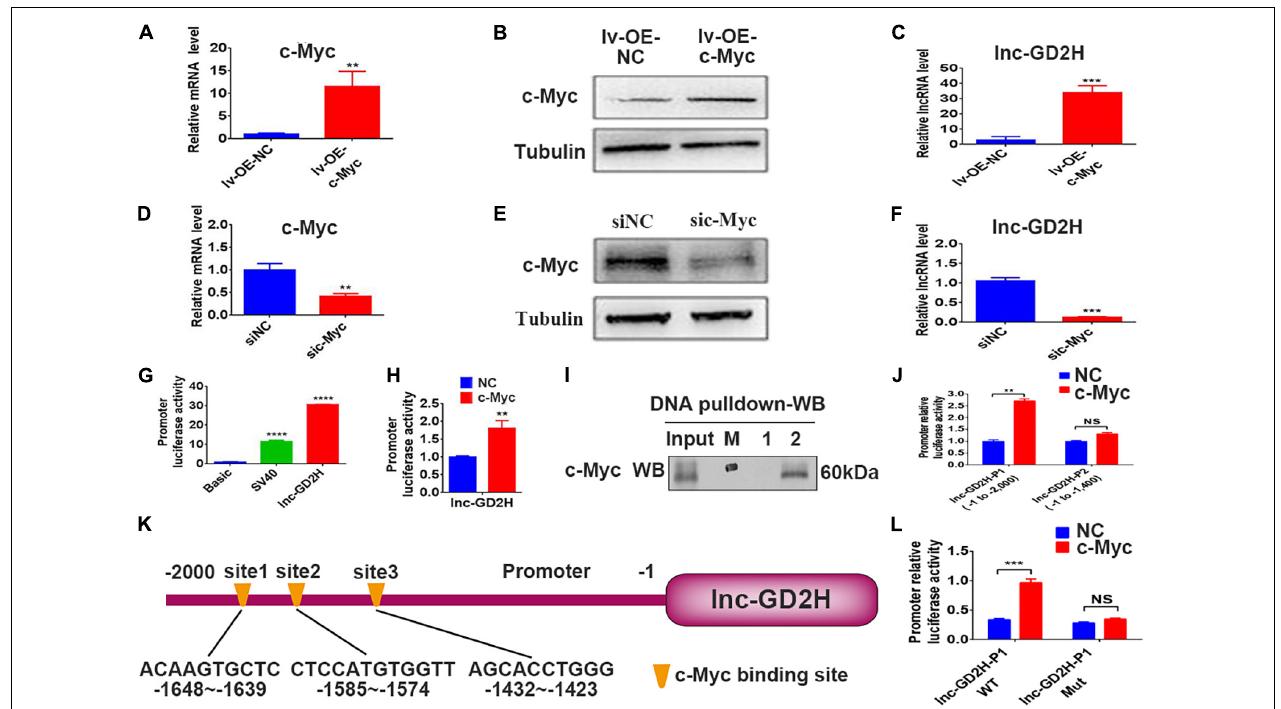
FIGURE 4 | c-Myc regulated the transcription of lnc-GD2H during myoblast proliferation. (A) c-Myc mRNA and (B) protein levels in c-Myc-overexpressing C2C12 cells. (C) Level of lnc-GD2H in c-Myc-overexpressing cells. (D,E) qPCR and western blotting confirmed the knockdown of c-Myc. (F) Level of lnc-GD2H in c-Myc-knockdown cells. (G) Luciferase activity of the lnc-GD2H promoter. (H) Luciferase activity of the lnc-GD2H promoter after transfection with c-Myc plasmid and the lnc-GD2H promoter. (I) A DNA pulldown assay was performed to confirm the association between the lnc-GD2H promoter and c-Myc. M: marker, 1: biotinylated control probe, 2: biotinylated lnc-GD2H-probe. (J) Luciferase activity of lnc-GD2H after wild-type promoter P1 (at approximate site –1 to –2,000) or promoter P2 (at approximate site –1 to –1,400) was transfected with c-Myc plasmid. (K) The JASPAR database was used to predict the promoter sequence lnc-GD2H binding site for c-Myc. (L) Luciferase activity of the wild-type lnc-GD2H promoter and three predicted simultaneously mutated c-Myc binding sites in the lnc-GD2H promoter, for determining the binding domain between the lnc-GD2H promoter and c-Myc. n = 3, ** P < 0.01, *** P < 0.001, **** P < 0.0001, NS: